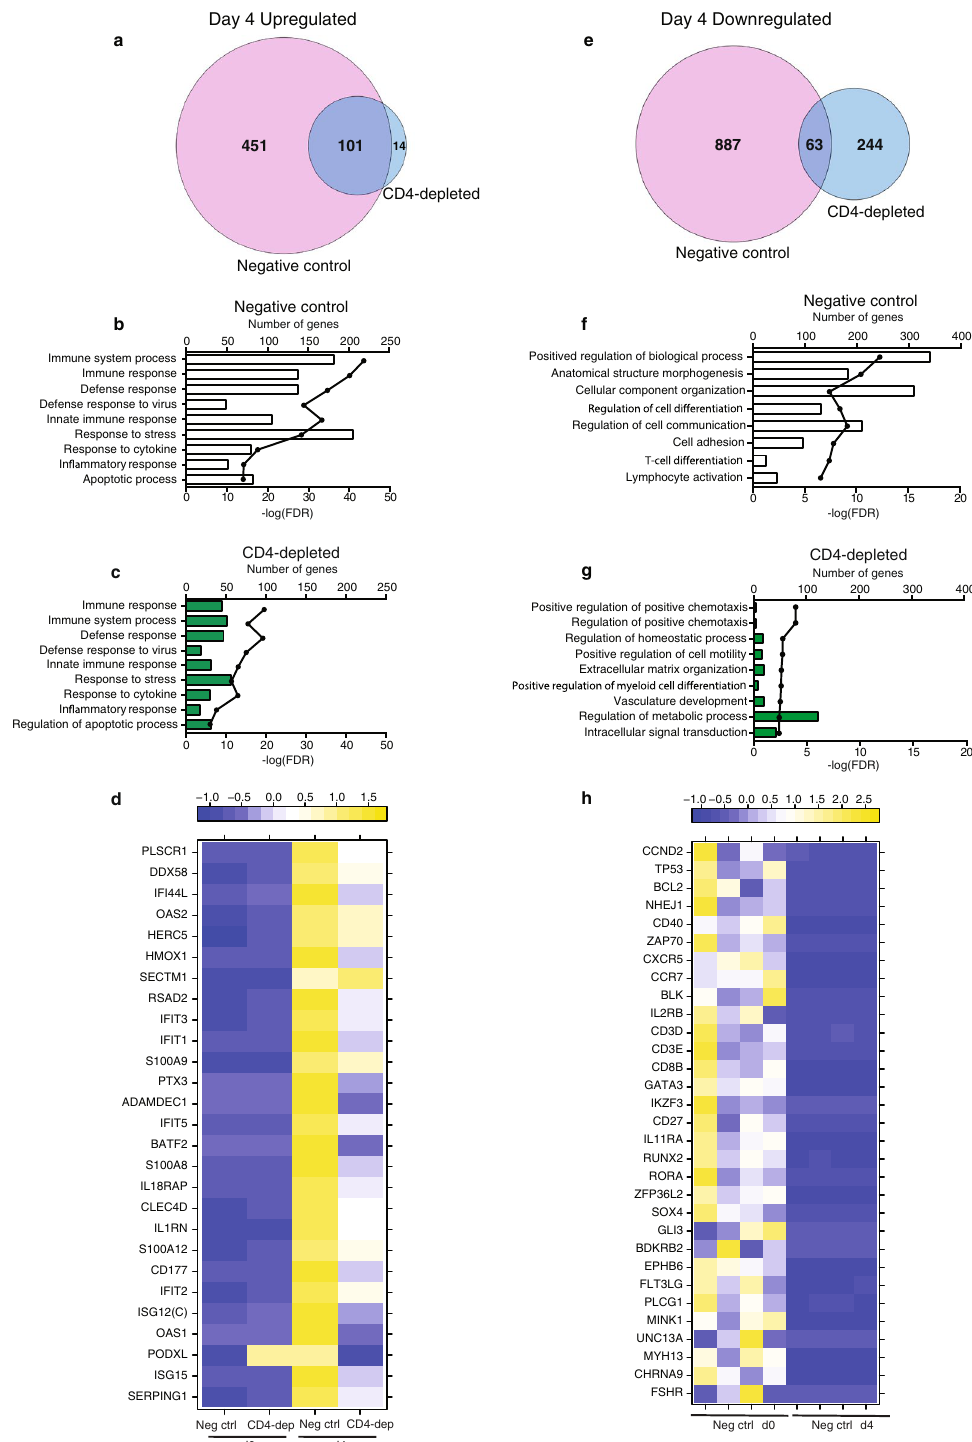
Figure 3. Partial protection in CD4-depleted group 4 dpi. ( a ) Venn diagram shows overlap between genes upregulated in negative control and CD4-depleted animals 4 dpi. ( b , c ) Bar graph depicting the most statistically significant GO terms to which upregulated DEGs in negative control animals ( b ) and CD4-depleted animals ( c ) enriched 4 dpi. ( d ) Heatmap of upregulated DEGs in both groups mapping to “Inflammatory Response” with a fold change cut off of 32 (based on negative control animals); each column shows median transcript RPKM counts of all 4 animals in each group. ( e ) Venn diagram comparing genes downregulated 4 dpi in negative control and CD4-depleted animals. ( f , g ) Bar graph depicting the most statistically significant GO terms to which down-regulated DEGs in negative control animals ( f ) and CD4-depleted animals ( g ) enriched 4 dpi. ( h ) Heatmap of down-regulated genes in negative control animals mapping to “Lymphocyte activation”, with a fold change cutoff of 15; each column represents 1 animal in the negative control